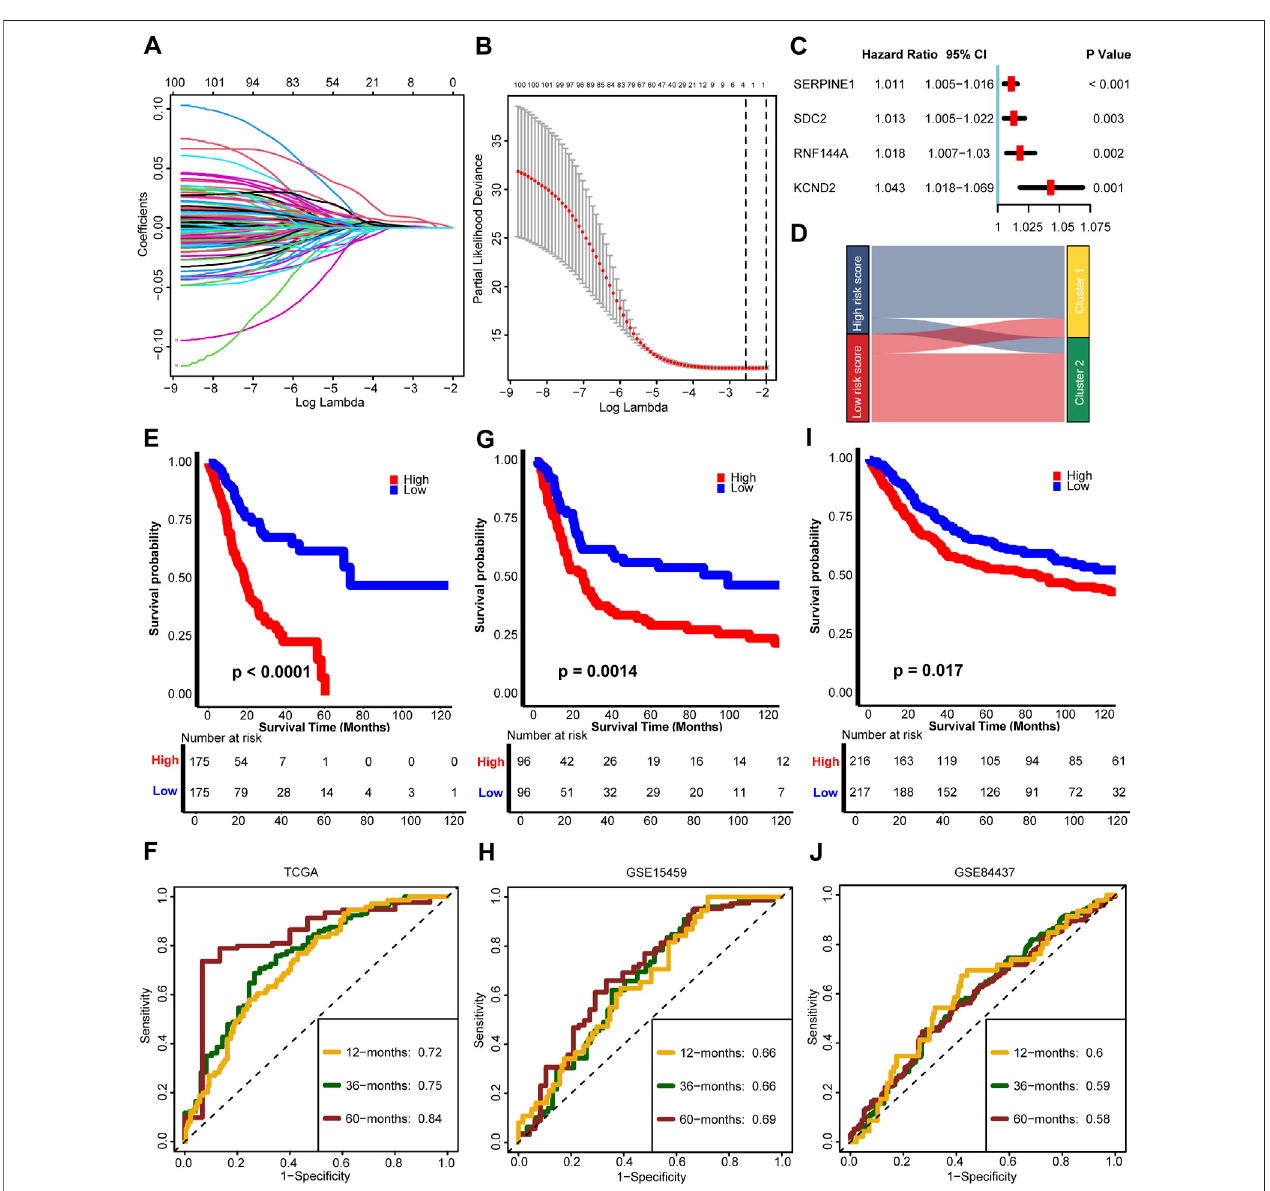
FIGURE3| DevelopmentandexternalvalidationofaTGF β riskscore. (A) Leastabsoluteshrinkageandselectionoperator(LASSO)coef fi cientcurvesshowthelog (lambda) sequence of 101 prognostic genes in the TCGA-STAD cohort. (B) Cross-validation for the selection of turning parameter selection by minimum criteria in the LASSOregressionmodel. Twodottedvertical lines using theminimum criteria wereplottedat theoptimal values.Four geneswiththe bestdiscriminative capabilitywere selected to develop the risk score. (C) Univariate Cox analysis of 4 predictor genes. (D) The relationship between the risk score and TGF β clusters. (E – J) Development and validation of the risk score in TCGA-STAD, GSE15459, and GSE84437 databases respectively and the predictive accuracy of the risk score for survival.